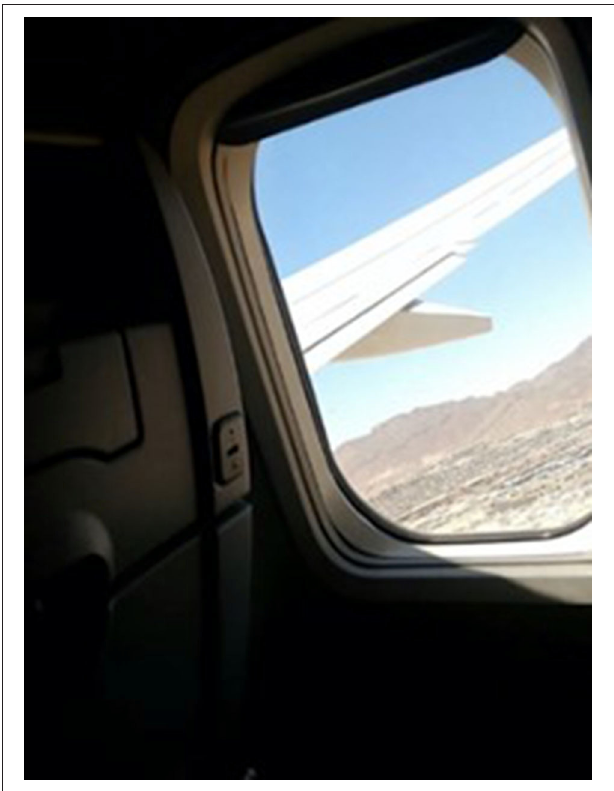
I Don’t See a Border, I See Hope